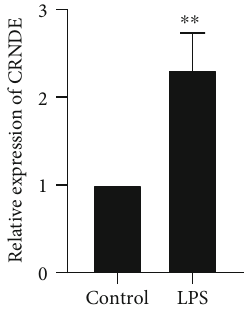
Figure 1: LPS-induced increase of lncRNA CRNDE expression in HK-2 cells. Compared with the control group, ∗∗ p < 0 : 01